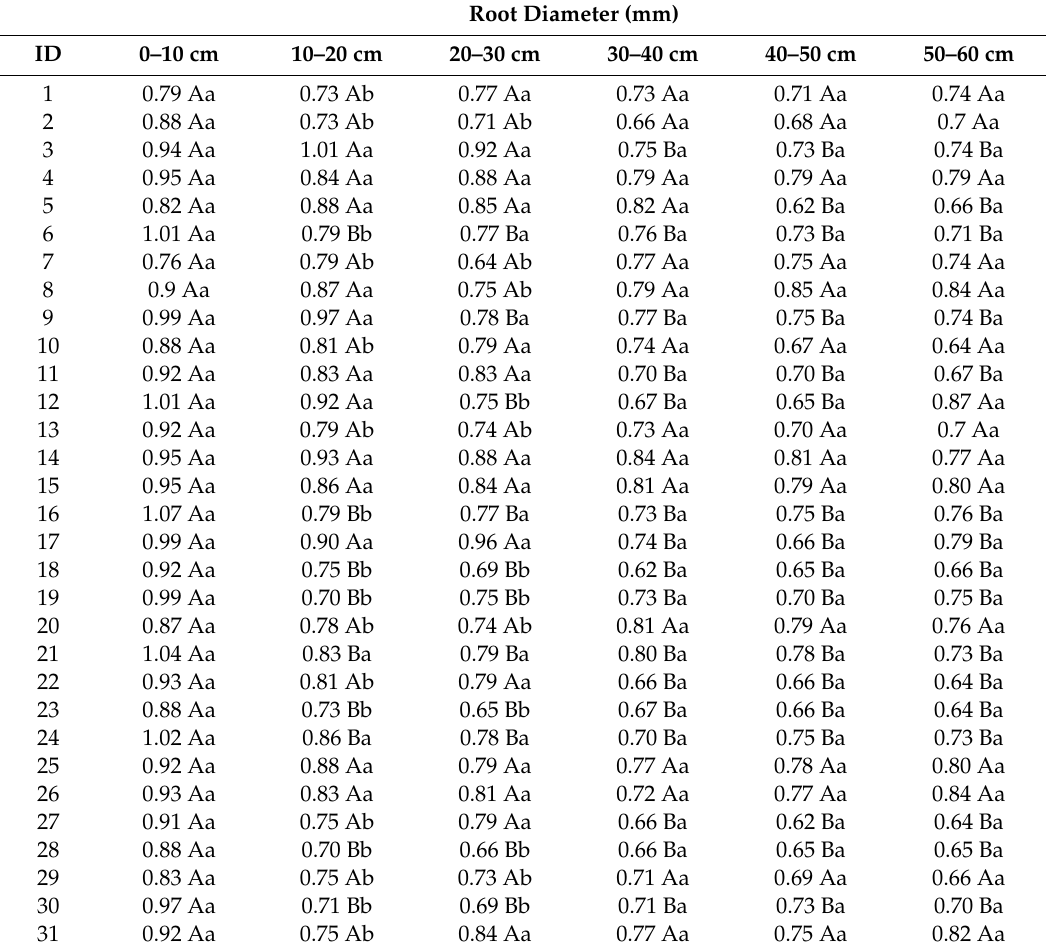
Table 6. Average root diameter of 43 C. canephora genotypes in six soil